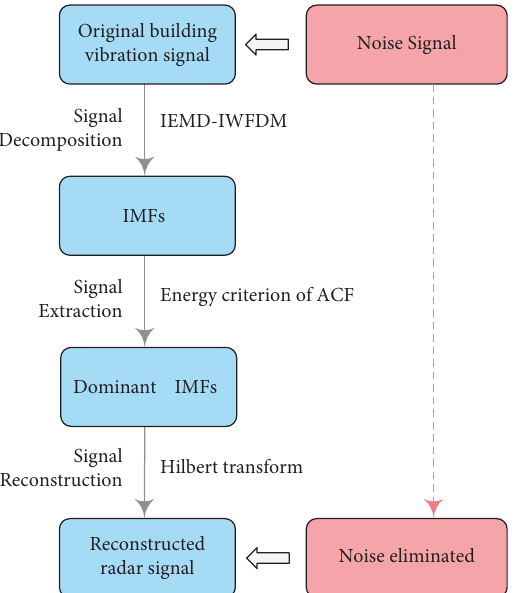
Figure 1: Procedure flowchart of building vibration signal